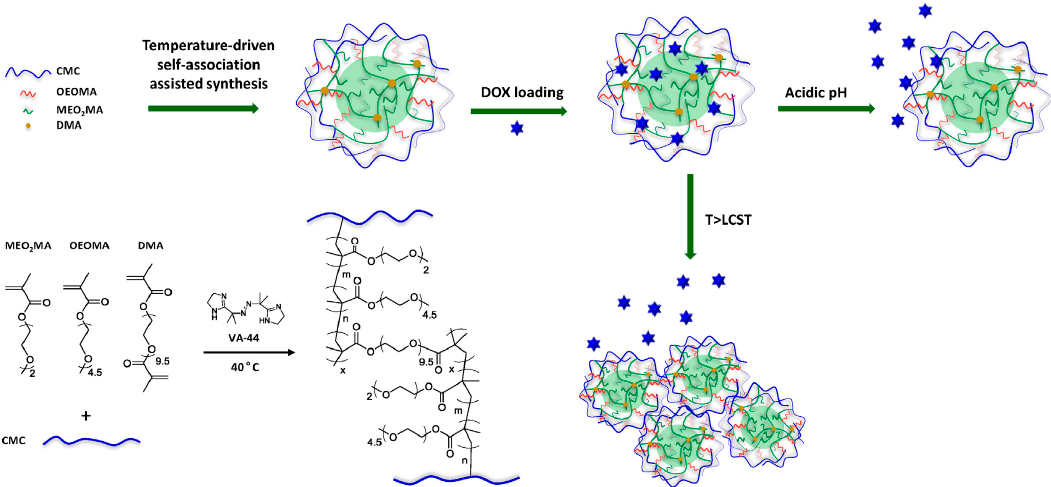
Figure 13. Synthesis of dual temperature/acidic pH-responsive dual temperature/acidic pH-responsive nanogels (DuR-BNGs) via temperature-driven self-association method and their dual stimuli-responsive doxorubicin (DOX) release. [132].